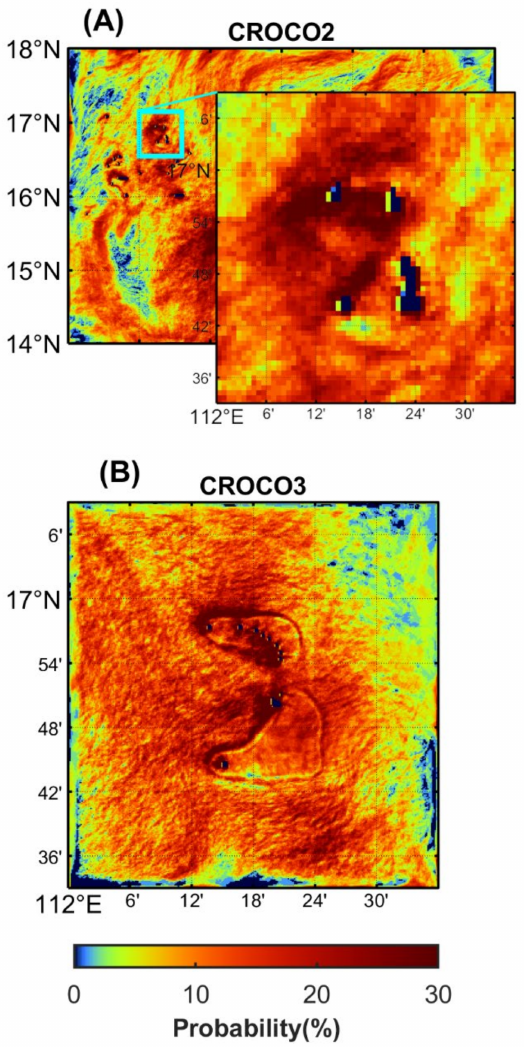
Figure 15. The distribution of SI activity probability around the Yongxing Island in CROCO2 ( A ) and CROCO3 ( B ) in January